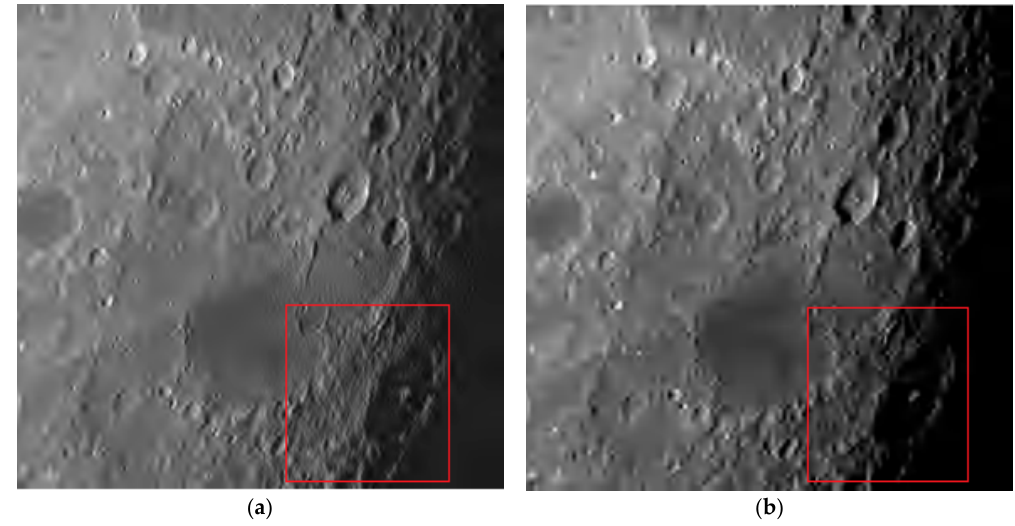
Figure 9. The comparison results of two compression algorithms with the image “Lunar” at 0.0625 bpp. ( a ) Reconstructed image with the proposed method and ( b ) reconstructed image with JPEG2000. Remote Sens. 2018 , 10 , x FOR PEER REVIEW